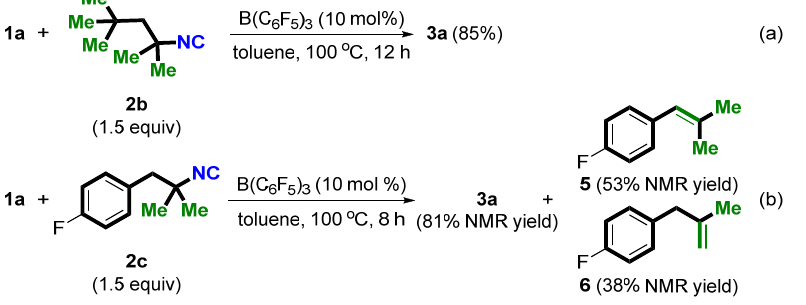
Table 1. Optimization of reaction conditions [a] .